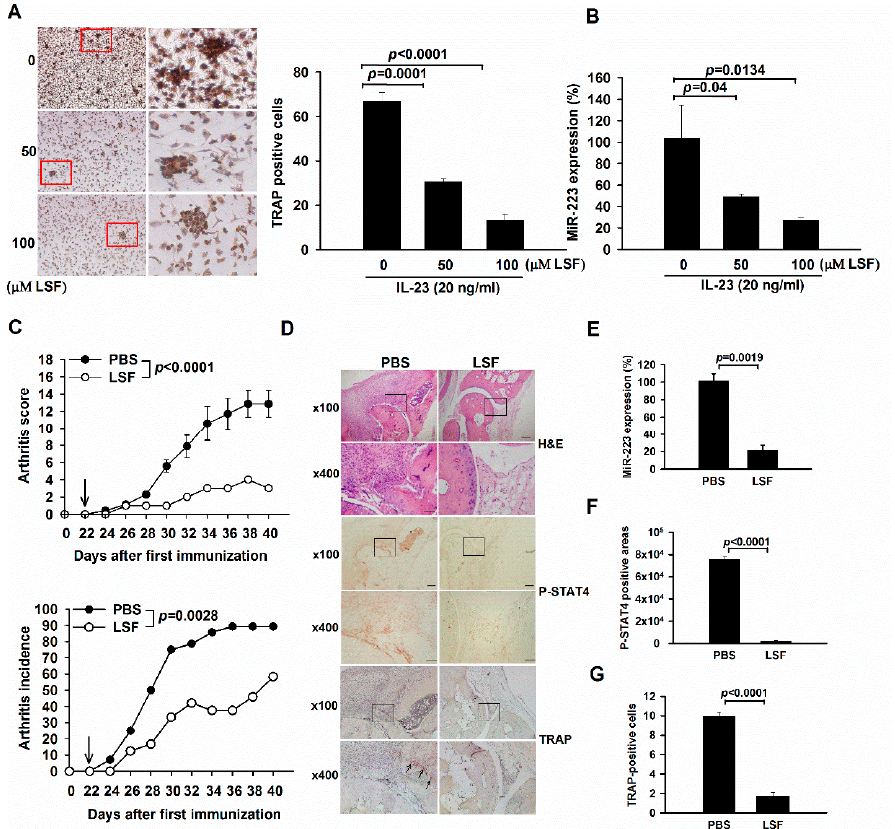
Figure 3. Lisofylline (LSF) treatment in BMMs and mice with CIA. ( A ) TRAP staining and quantifi- cation in LSF (50 and 100 µ M)-treated BMMs upon stimulating with IL-23 (20 ng/mL). Each value shown represents the mean ± SEM ( n = 3). Red boxed areas are shown at higher magnification in the panels next to them. Scale bars represent 200 µ m in × 100 magnifications. ( B ) Expression of miR-223 in BMMs treated with various concentrations of LSF in response to IL-23 (20 ng/mL) stimulation for 12 h, as determined by qRT-PCR. Each value shown represents the mean ± SEM ( n = 3). ( C ) Arthritis score and incidence in mice with CIA through intraperitoneal injections of LSF (50 mg/kg) and PBS daily from day 22 to 36. Arrows indicate the time at which LSF was injected. Each value shown represents the mean ± SEM (PBS: n = 6, LSF: n = 6). ( D ) Representative images of the ankle sections by hematoxylin and eosin staining on day 40. Scale bars represent 200 and 50 µ m in × 100 and × 400 magnifications, respectively. Each value shown represents the mean ± SEM ( n = 6). Black boxed areas were shown at higher magnification in the panels ( × 400) beneath them. Expression of ( E ) miR-223, ( F ) phospho-STAT4 (p-STAT4) and ( G ) the number of TRAP-positive cells in joint extracts of LSF and PBS-injected mice with CIA, as determined by qRT-PCR. Each value shown represents the mean ± SEM ( n = 6). Results are representative of two independent